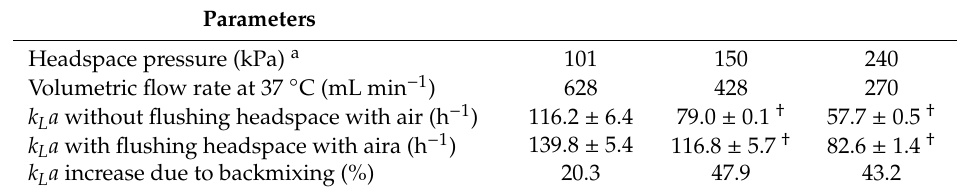
Table 2. E ff ect of headspace pressure and backmixing on k L a for O 2 in a sparged CSTR with 3 L working volume at standard air flow rate of 600 sccm and 900